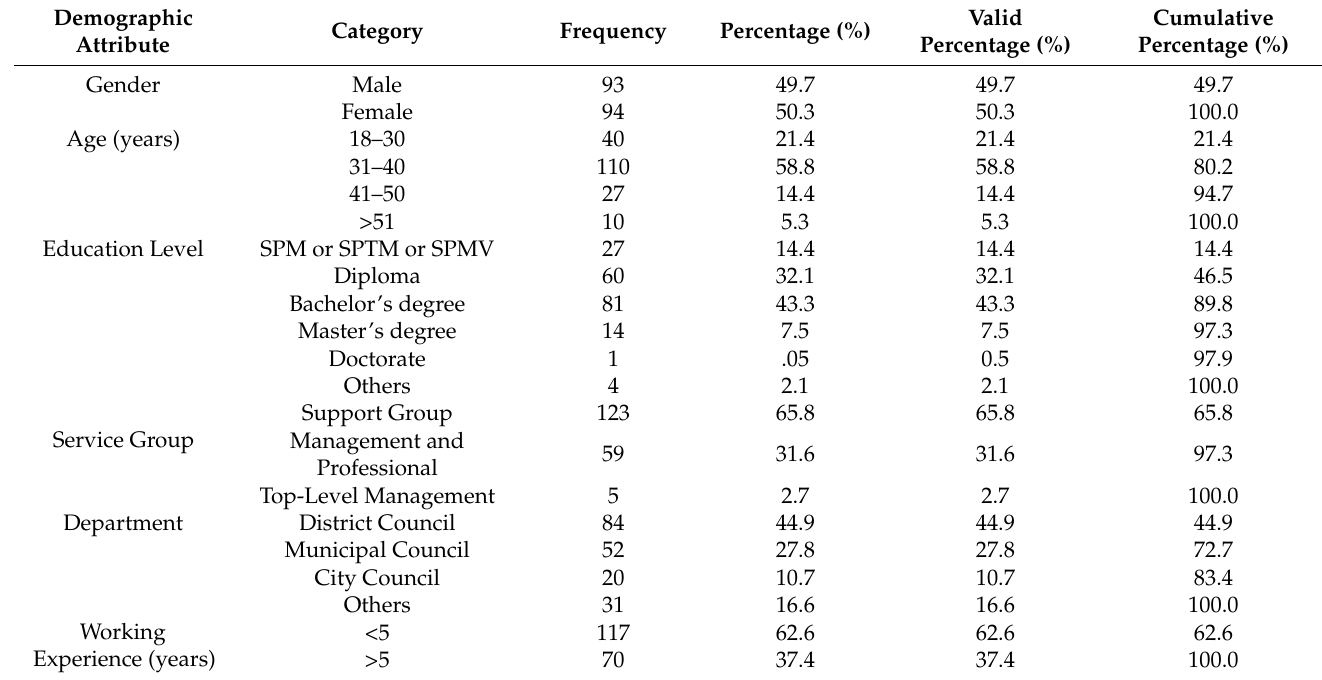
Table 4. Frequency distribution of descriptive